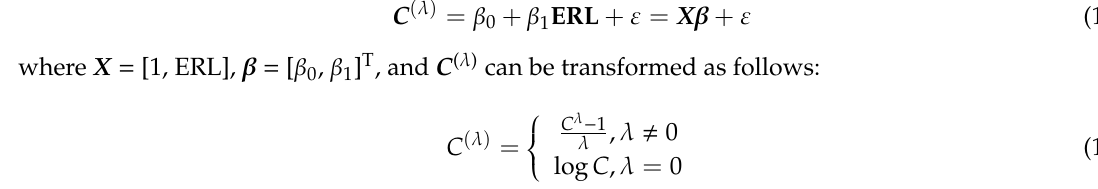
Figure 6. Log-likelihood function with parameter λ . 4.3. Estimation Result